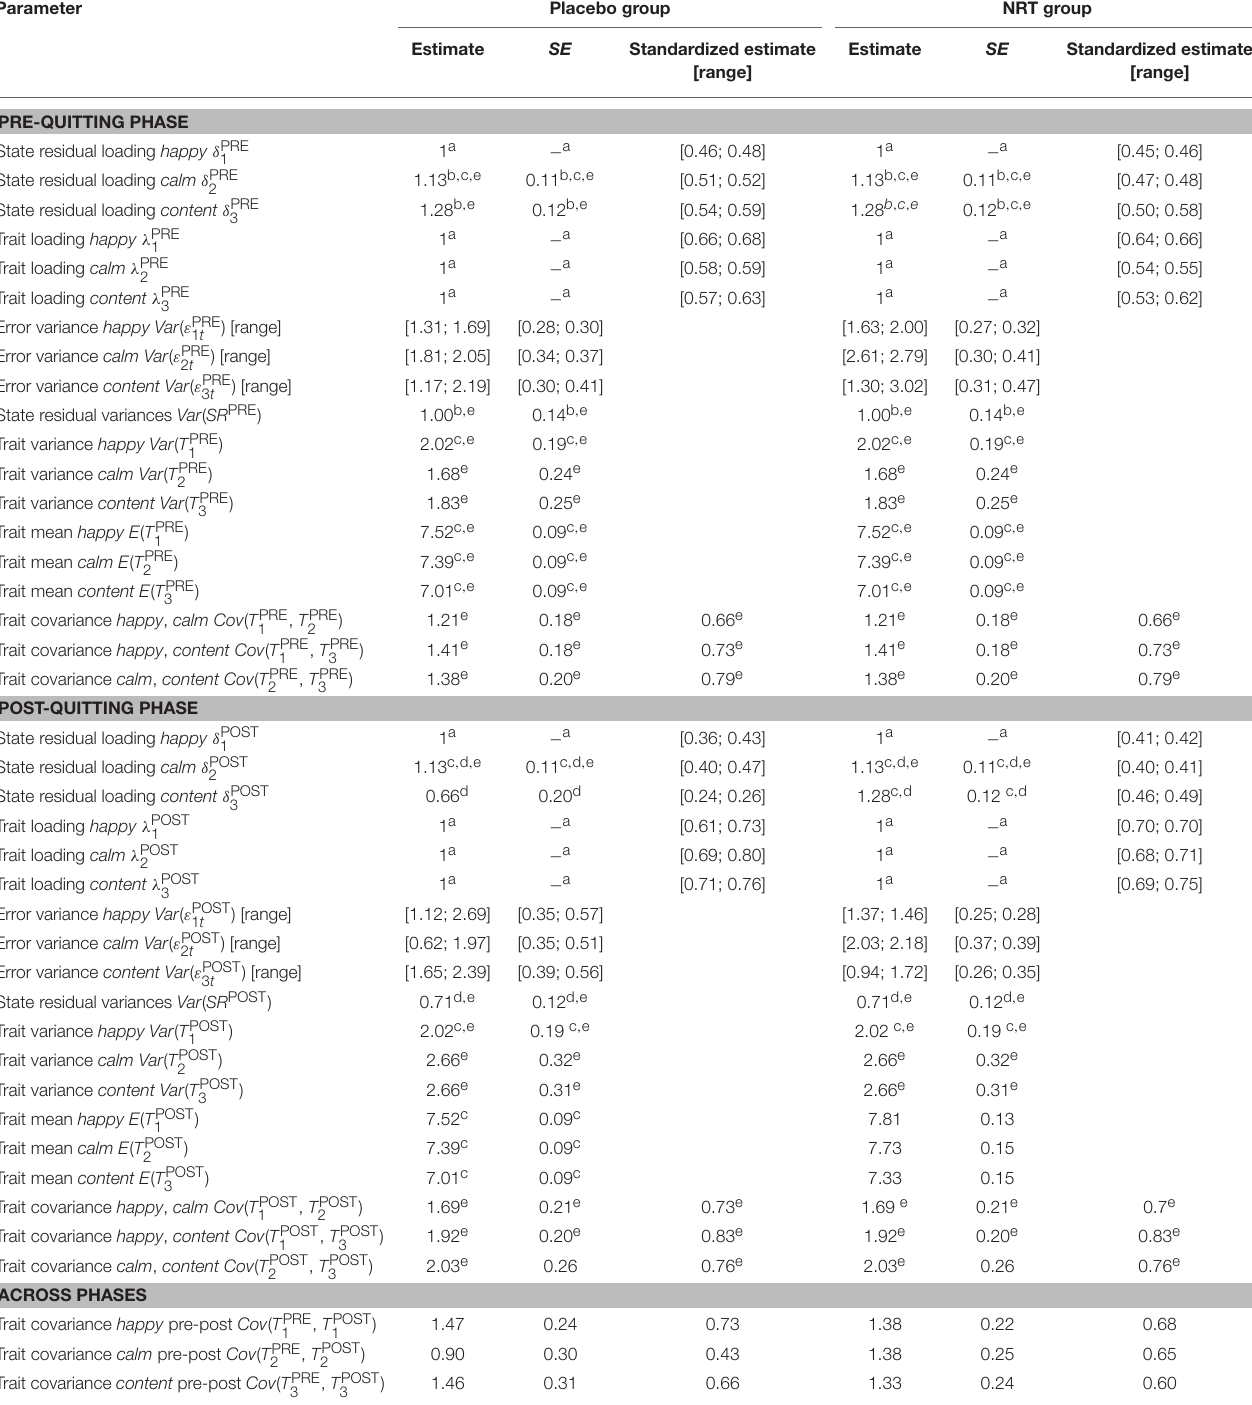
a fixed parameter. b Parameter set equal across time within the pre-quitting phase. c Parameter set equal across the pre- and post-quitting phases. d Parameter set equal across time within the post-quitting phase. e Parameter set equal across placebo and NRT